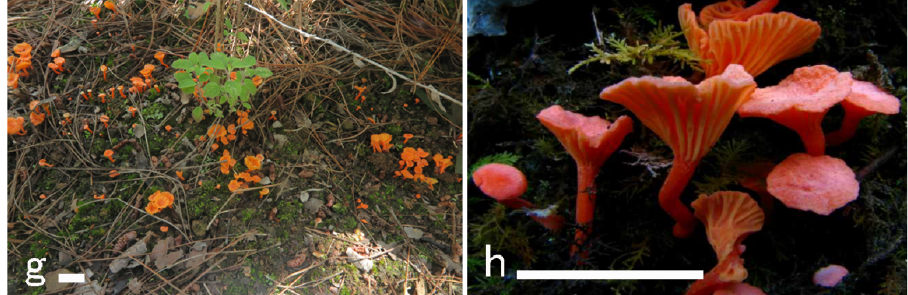
Figure 4. Basidiomata of Cantharellus sinocinnabarinus. ( a , c ) GDGM83230. ( b ) GDGM83232. ( d ) GDGM83229. ( e ) GDGM832296. ( f ) GDGM83027. ( g ) GDGM83238. ( h ) HKAS58243. Bars = 2 cm.